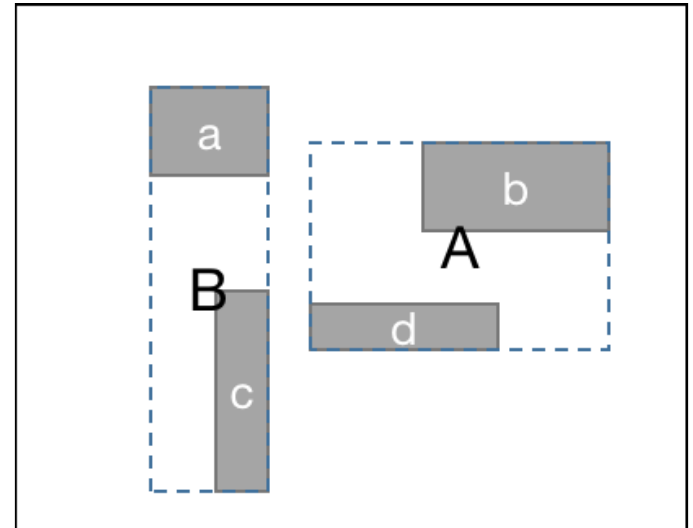
Figure 5. schematics of split